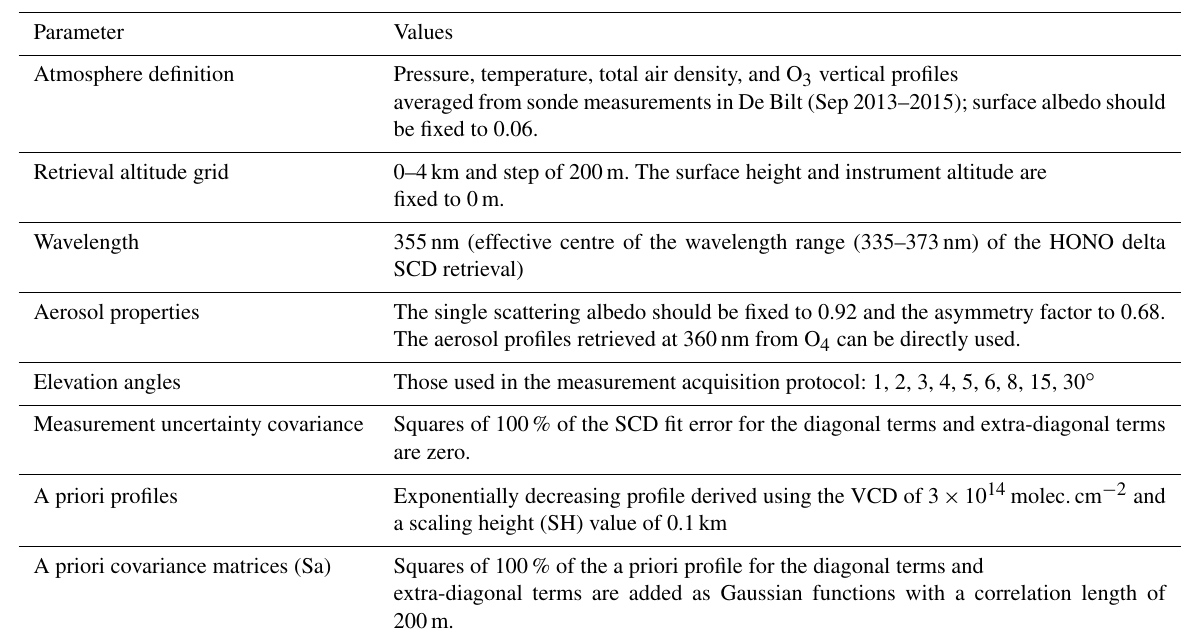
Table 3. Common settings of the HONO profile